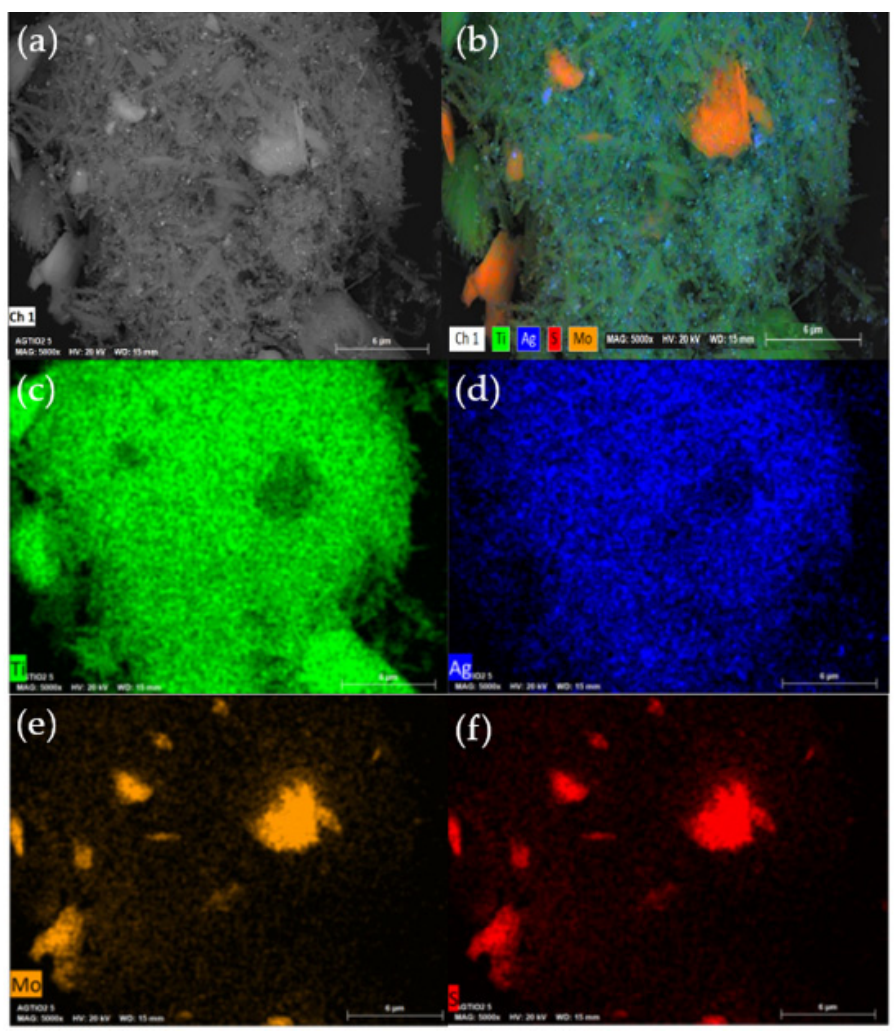
Figure 2. FE-SEM ( a ) and EDS images ( b–f ) of the 5Ag%TiO 2 NWs-5%MoS 2 catalyst.